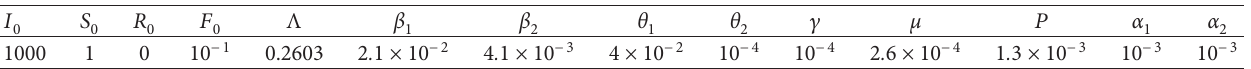
, S , R , and F 0 0 0 0